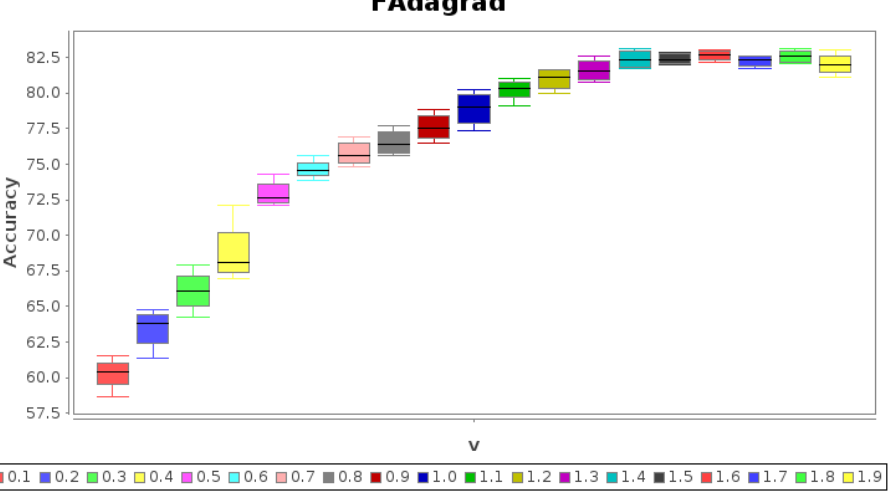
Figure 6. Experiment 2.1: FAdagrad cross-folding accuracies, K = 4 folds, ν ∈ [ 0.1,1.9 ] .